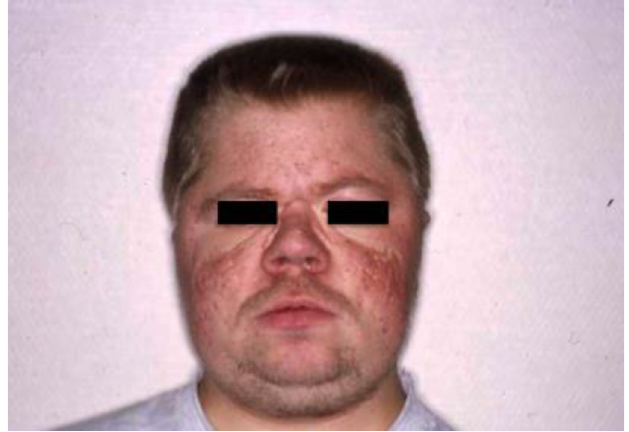
Fig. 2. Extraoral examination. The facial examination presents a severe acne with papulo-pustular lesions and comedons, a mesiofacial typology and a class III pro fi le. The central third of the face appears smaller than the frontal and lower